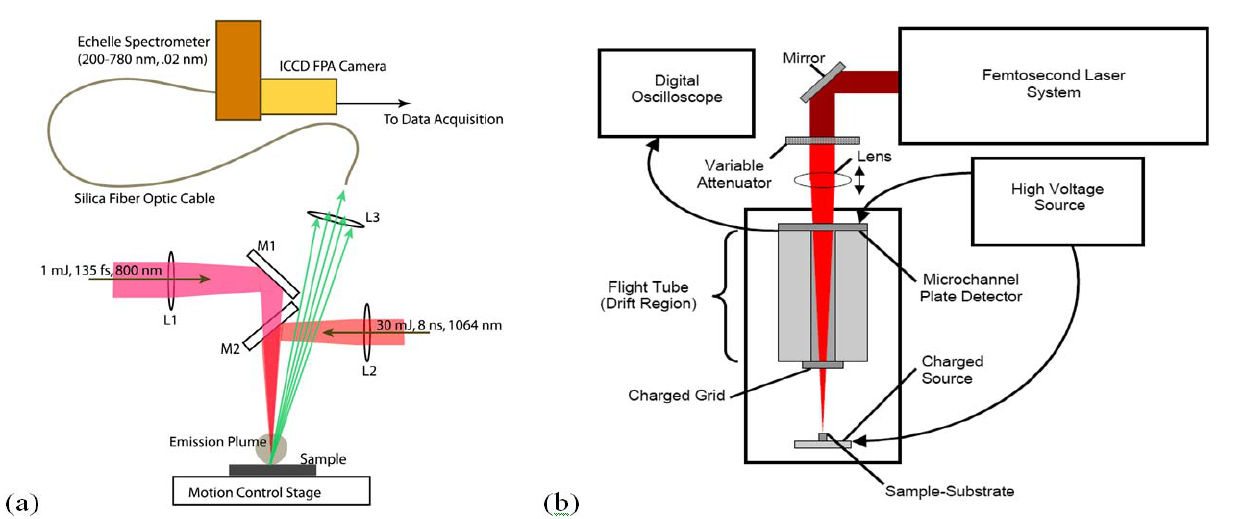
Figure 1. S chematic diagrams of the experimental apparatus used to collect (a)